Question: State the chart type depicted above.
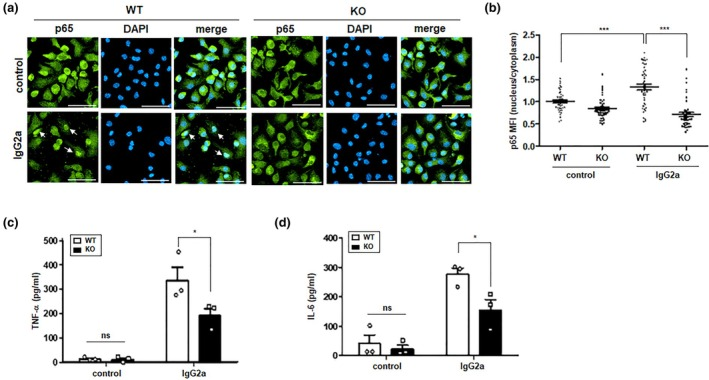
Answer: bar